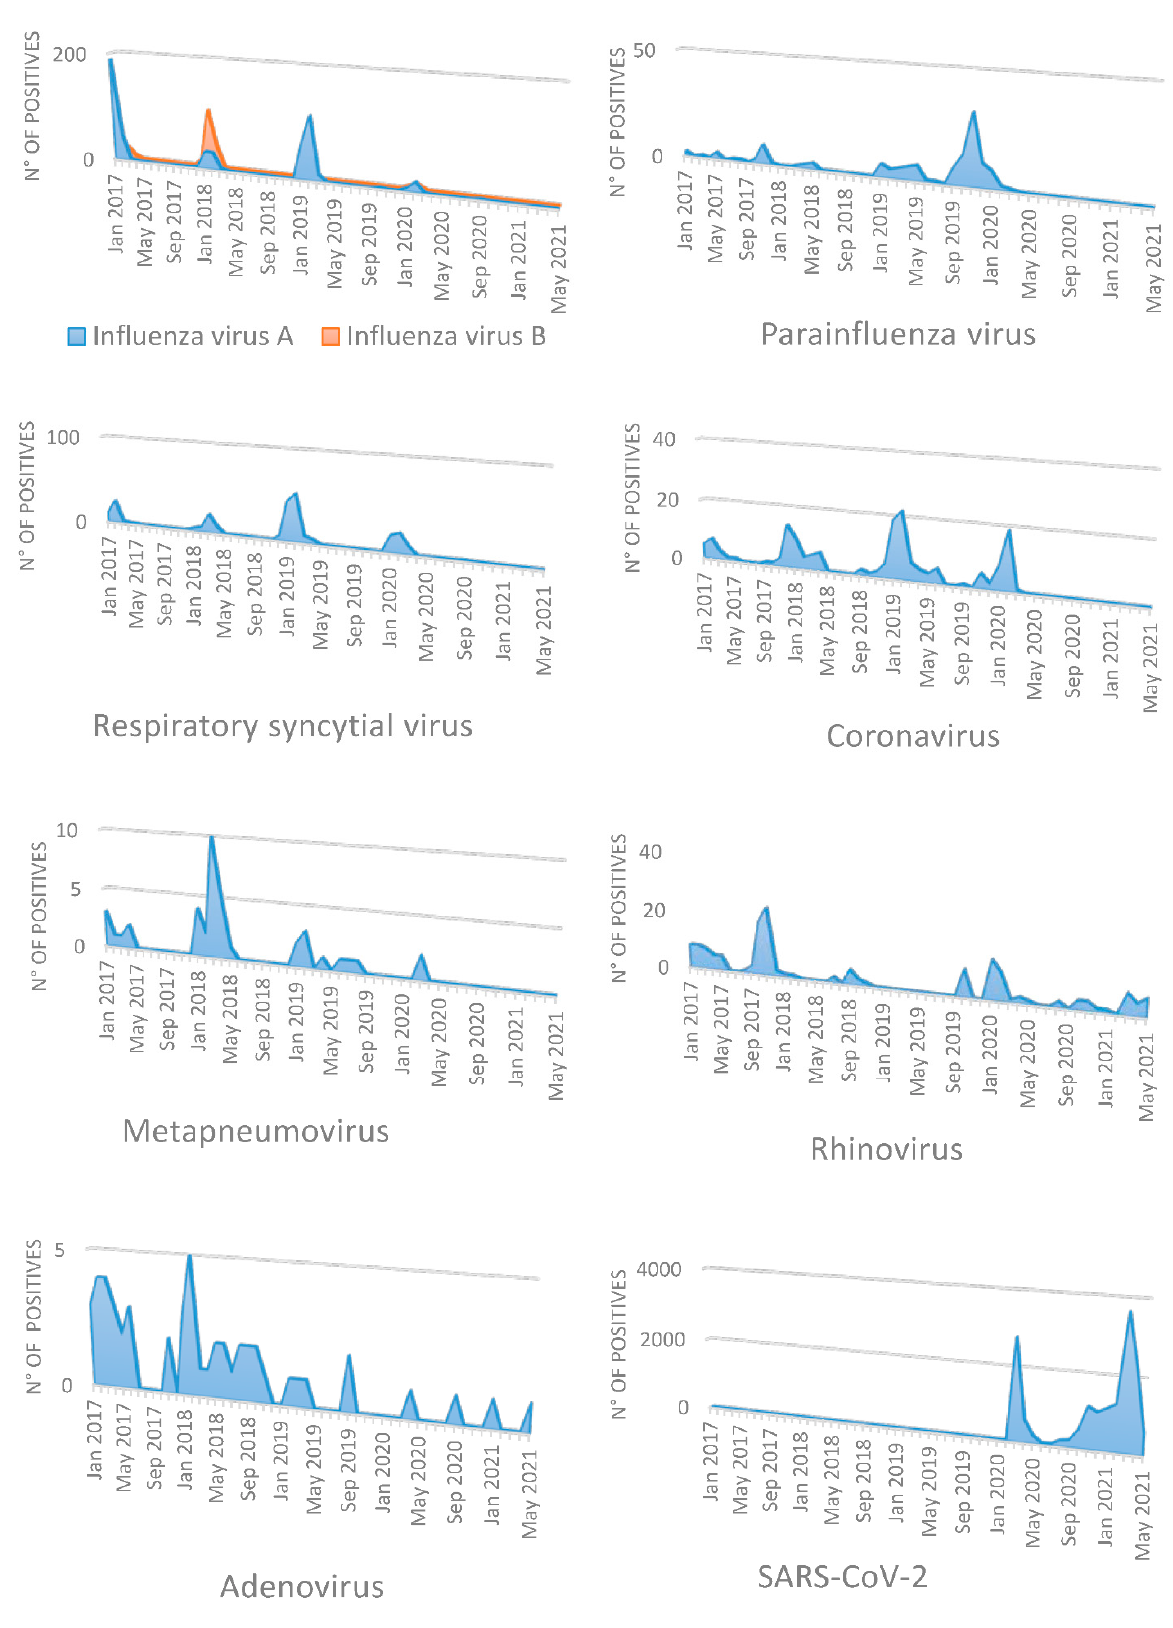
Figure 1. Monthly positive cases of respiratory pathogens in the pandemic period (March 2020–May 2021) in comparison with monthly positive cases in the pre-pandemic period (January 2017–February 2020). Reported positive cases of SARS- CoV-2 are displayed for comparison.